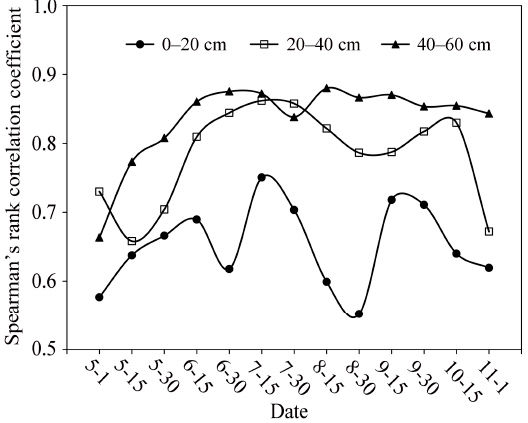
Figure 5. Mean Spearman’s rank correlation coefficients ( r s ) of VSM corresponding to different time lags in different depths.